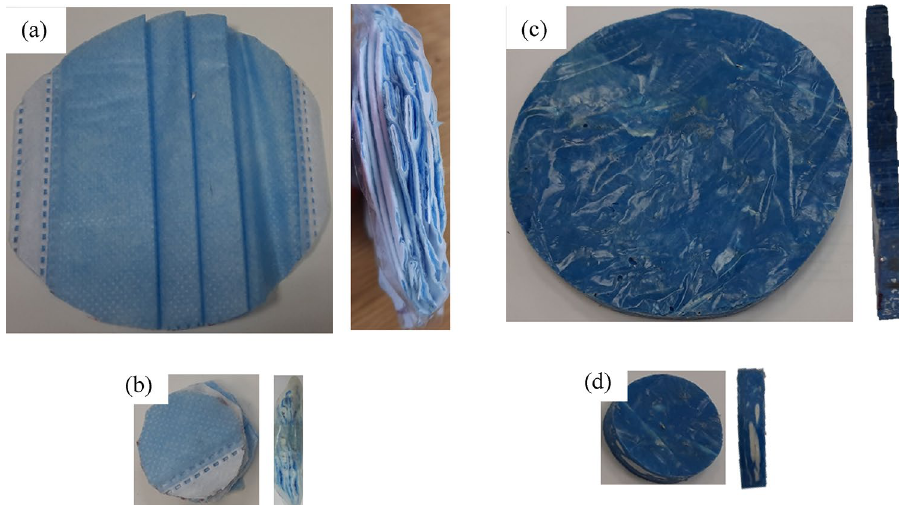
Figure 7. Sampled used for acoustic measurement; ( a ) 10 cm diameter loose masks with 12 mm thickness, ( b ) 3 cm diameter loose masks with 11 mm thickness, ( c ) 10 cm melted masks, and ( d ) 3 cm melted masks.